Question: Provide a publication-style caption for this figure.
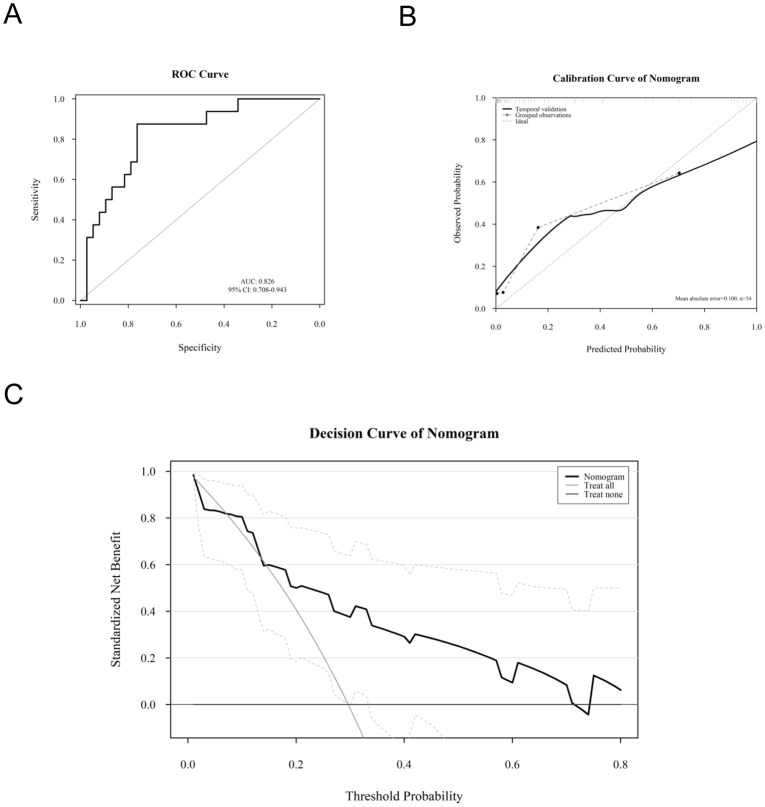
Answer: Temporal validation of the nomogram model. (A) Receiver operating characteristic (ROC) curve of the fixed nomogram model in the temporal validation cohort, with an area under the curve (AUC) of 0.826 and a 95% confidence interval of 0.708-0.943, indicating good discriminative ability. (B) Calibration curve of the nomogram in the temporal validation cohort, showing the agreement between predicted probability and observed outcomes. The solid line represents the calibration curve in the temporal validation cohort, the points indicate grouped observations, and the dotted line represents the ideal reference line. The mean absolute error was 0.100. (C) Decision curve analysis (DCA) of the nomogram in the temporal validation cohort. The thick black line represents the net benefit of the nomogram, the gray oblique line represents the “treat-all” strategy, and the black horizontal line represents the “treat-none” strategy across a range of threshold probabilities. The light gray dashed lines indicate the bootstrap-based confidence interval of the nomogram net benefit. ROC, receiver operating characteristic; AUC, area under the curve; DCA, decision curve analysis.